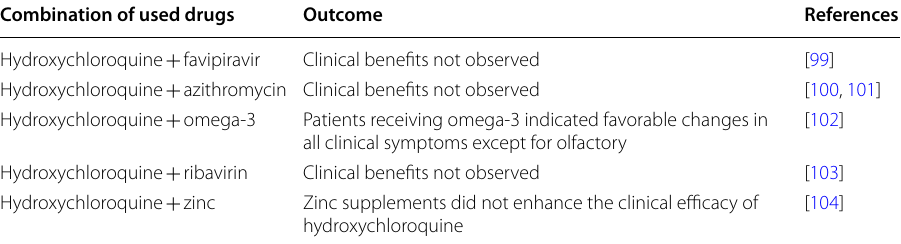
Table 2 Combined therapies of hydroxychloroquine with other drugs tested for